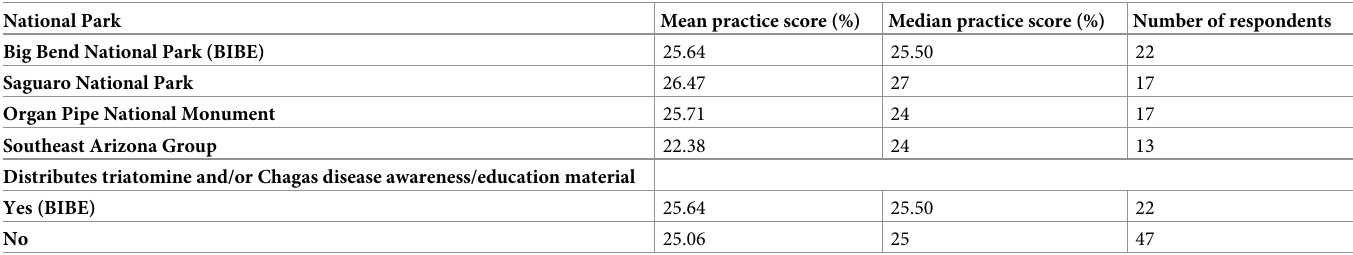
Table 4. Mean and median practice scores by national